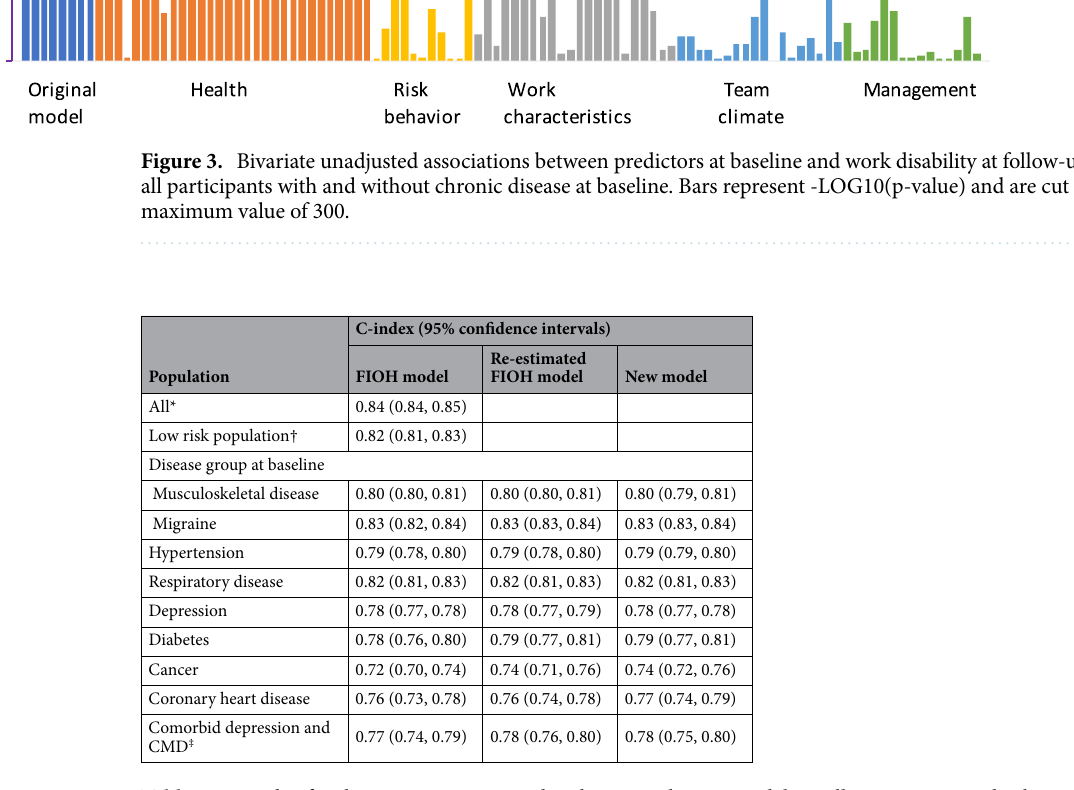
Table 3. C-index for the FIOH, re-estimated and new prediction models in all participants and subgroups of individuals with no history of sickness absence and those with a chronic condition at baseline. *Participants with and without chronic conditions at baseline. † Participants with no sickness absence at baseline. ‡ CMD, cardiometabolic disease (diabetes or coronary heart